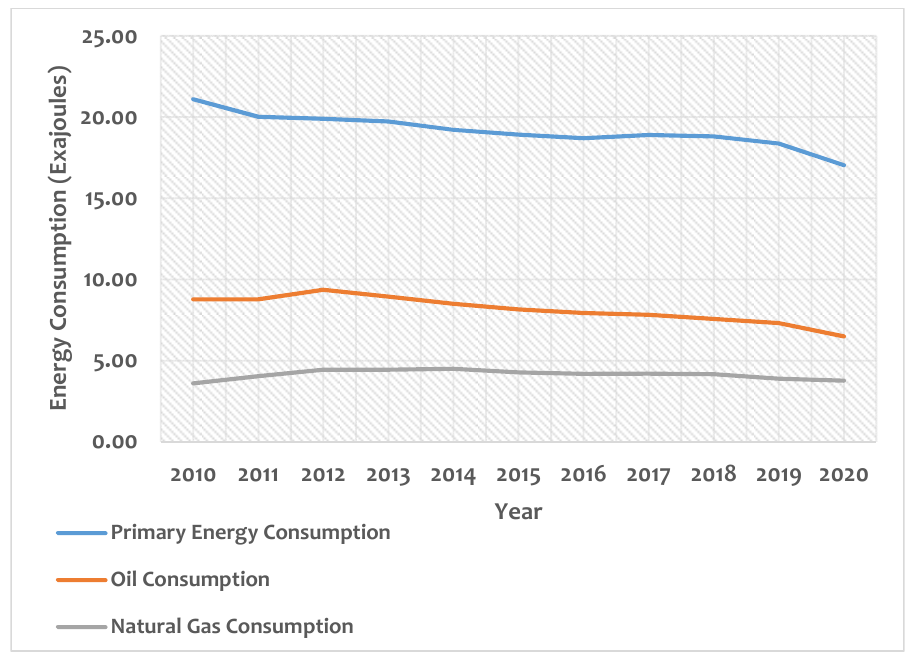
Figure 2. Japanese energy consumption based on data from [4].